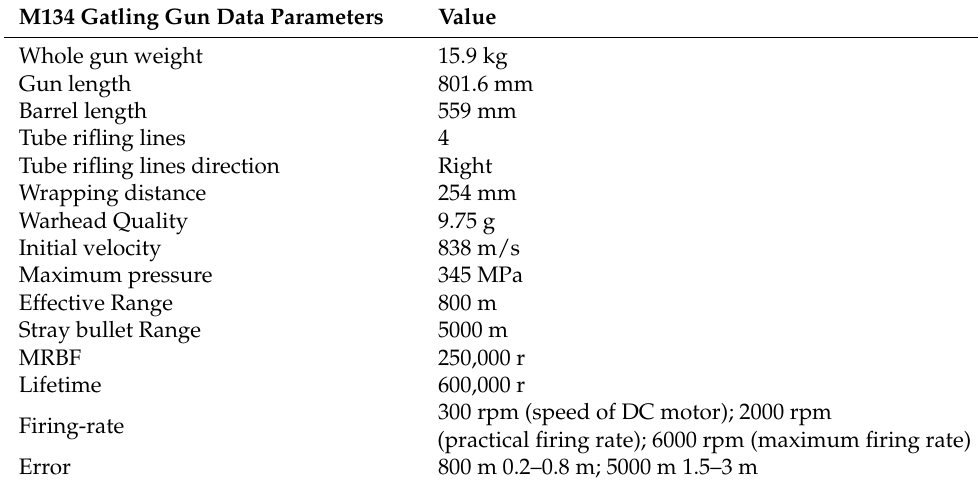
Figure 5. Lateral force F 1 and axis force F 2 . Table 1. Data of M134 [13–15] are shown.